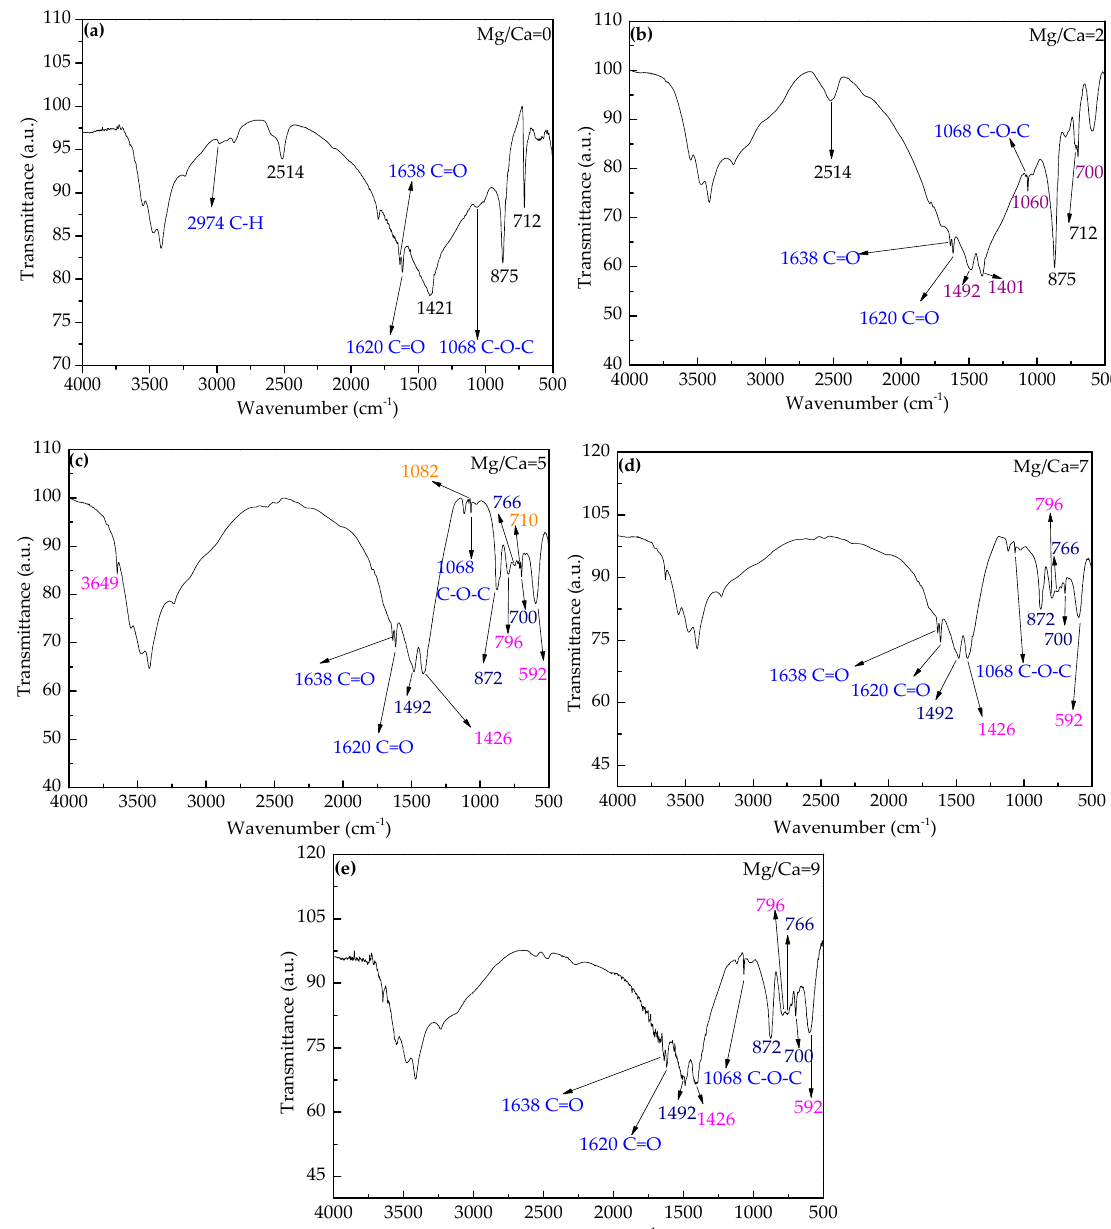
Figure 6. FTIR analyses of the biominerals cultured for 30 days. ( a ), ( b ), ( c ), ( d ), and ( e ) represents the minerals cultured at Mg/Ca ratios of 0, 2, 5, 7 and 9, respectively.